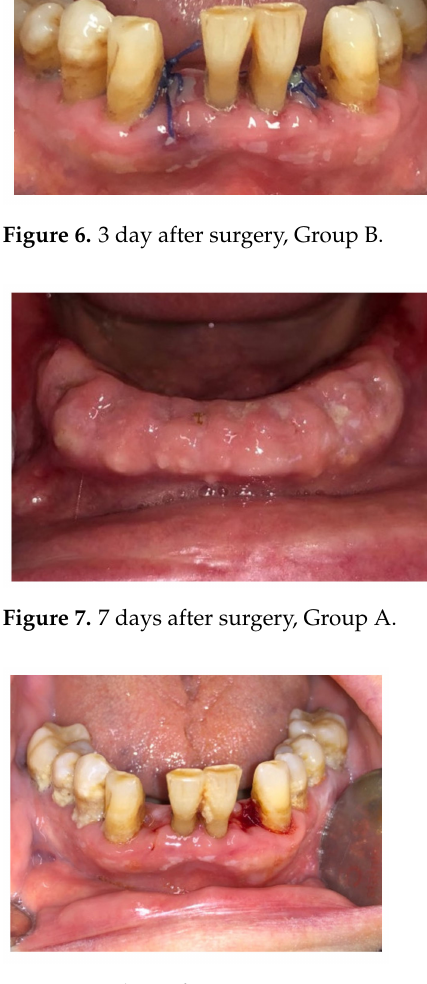
Figure 8. 7 days after surgery, Group